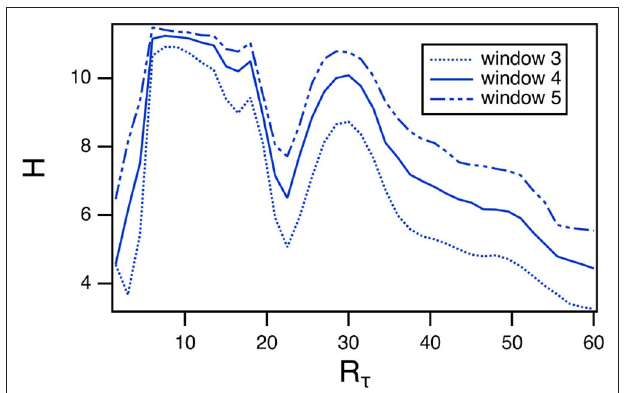
FIGURE 5 | Permutation entropy H calculated using different window lengths as a function of the fast to slow time ratio R τ for the spiking reservoir computer driven by Sprott system B. For this plot, γ = 0.004 and R τ =